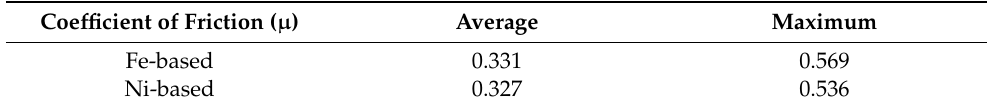
Table 10. Friction coefficients and wear rates of the cladding layer.